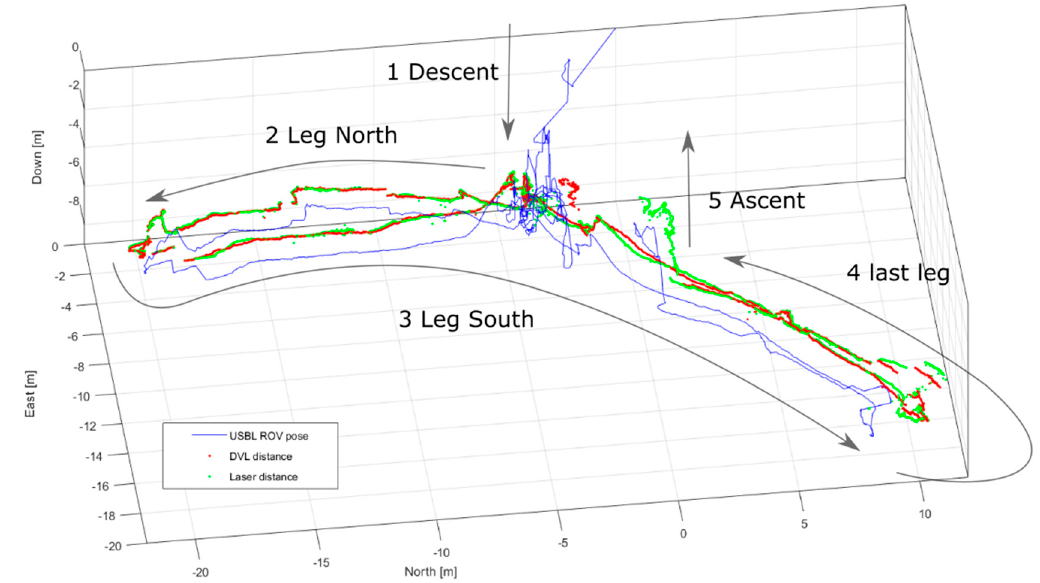
Figure 13. A Kalman filter estimate of the experiment showing the descent, navigation along the net pen, and the ascent.